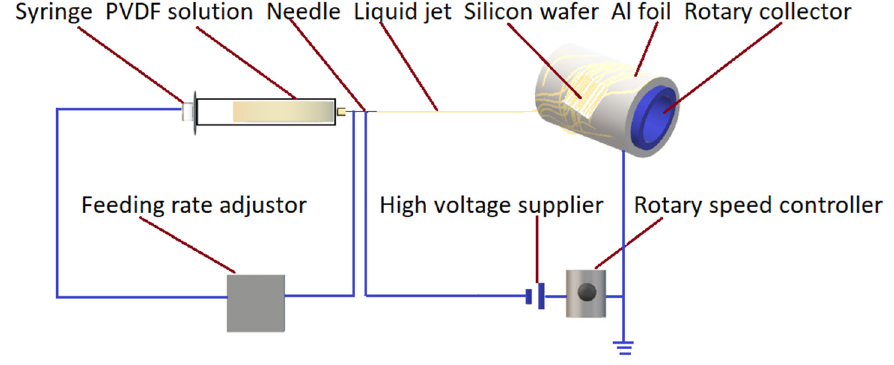
Figure 2. Schematic of the electrospinning